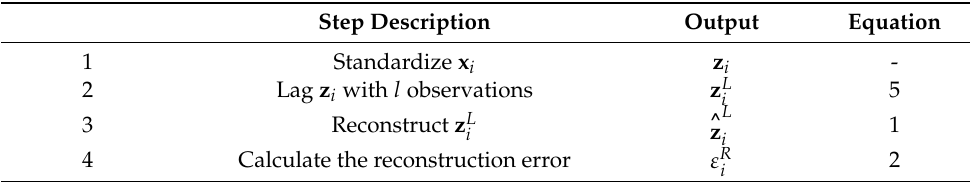
Table 5. dPCA, AE, and CAE application